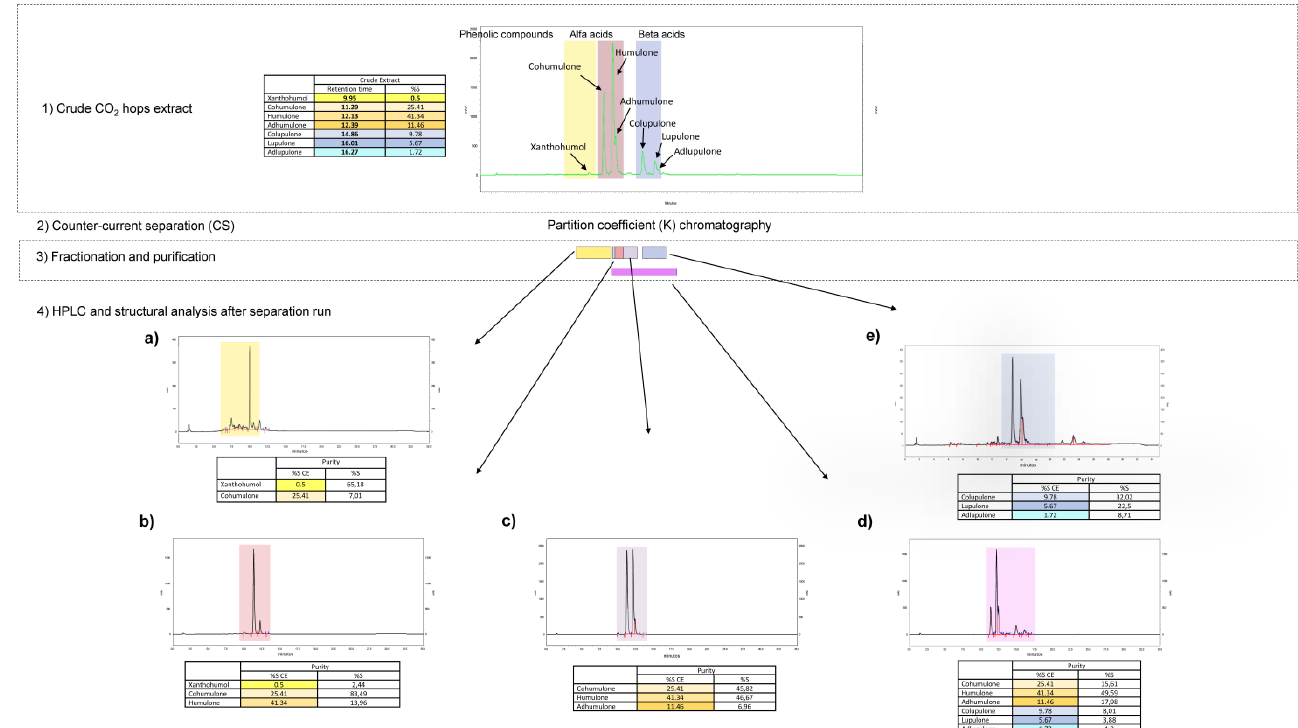
Figure 2. Steps of the purification process of the hops compounds: (1) HPLC chromatogram identifying compounds to purify in H. lupulus crude extract, with table indicating retention times of each identified compound and surface area in %; (2) CCS instrument purification step; (3) fractionation and purification of compounds; (4) HPLC chromatograms of each isolated compound, with table indicating their quantities in the crude extract assessed with the purification range: ( a ) xanthohumol and phenolic compounds; ( b ) cohumulone; ( c ) α -acids; ( d ) α - and β -acids; ( e ) β -acids.